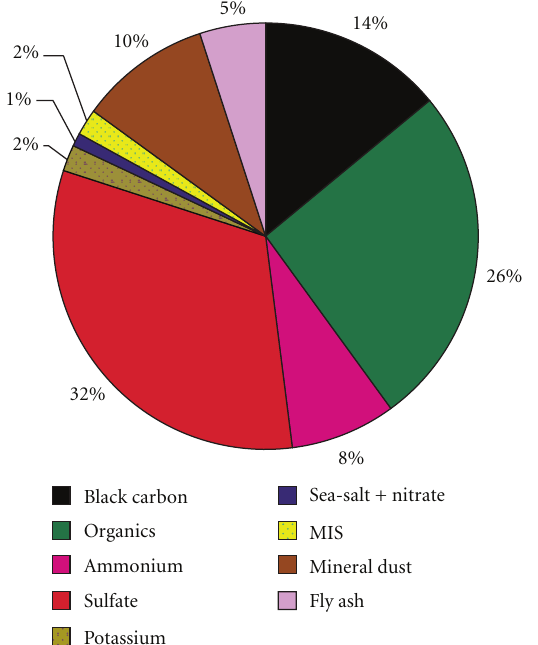
Figure 1: Fractional contribution of chemical components to the INDOEX aerosol, as measured over the Indian Ocean by aircraft in February and March 1999